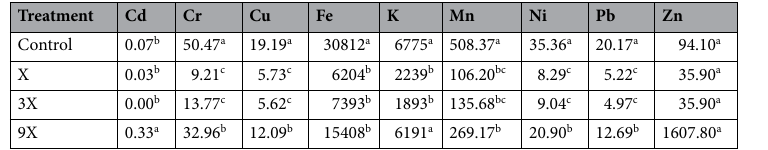
Table 5. Average heavy metals accumulation concentrations in soil [ppm]. Means in the same column with similar superscripts are not statistically different (Duncan test, P ≤ 0.05).